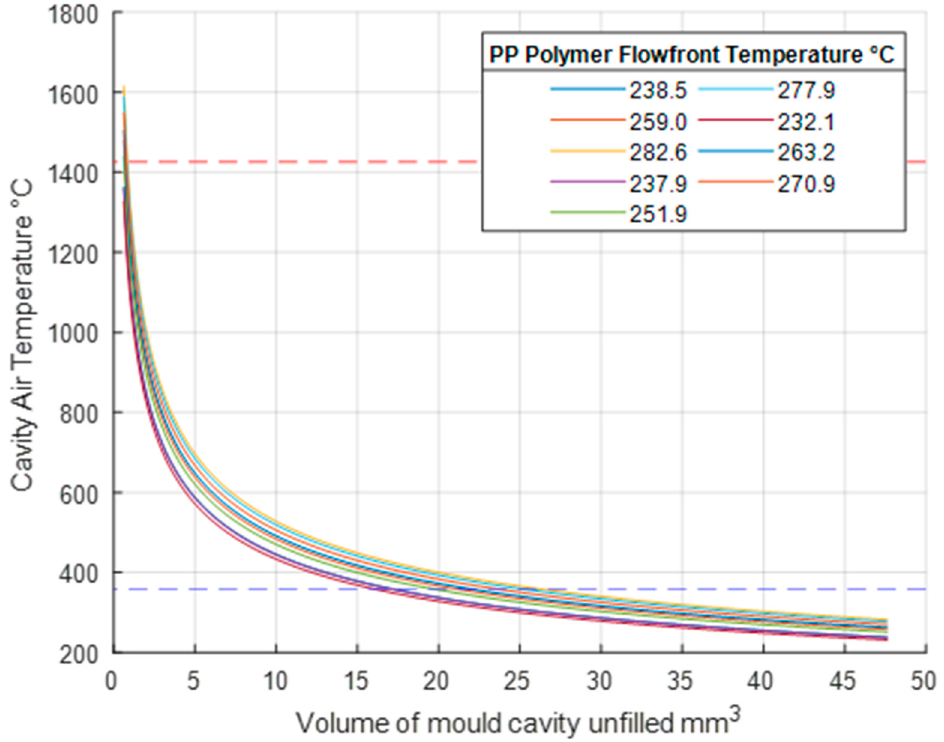
Figure 7. Adiabatic temperature increase when air is compressed in mould, PP.